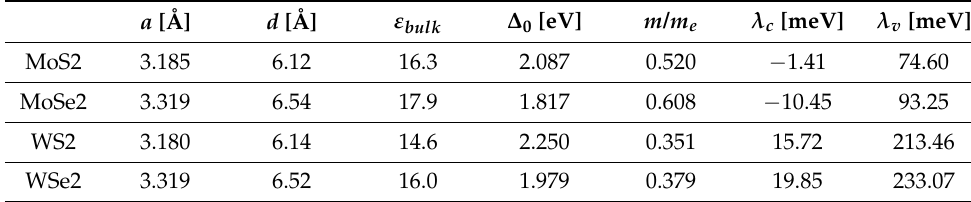
Table 1. Model parameters for TMDC MLs: lattice constant a , effective mass m in units of free electron mass m e , and spin-orbit couplings λ c , v are taken from Reference [61]. The layer thickness d and bulk dielectric constant ε bulk are from Reference [64], and bandgap ∆ 0 is from Reference [60] (see model